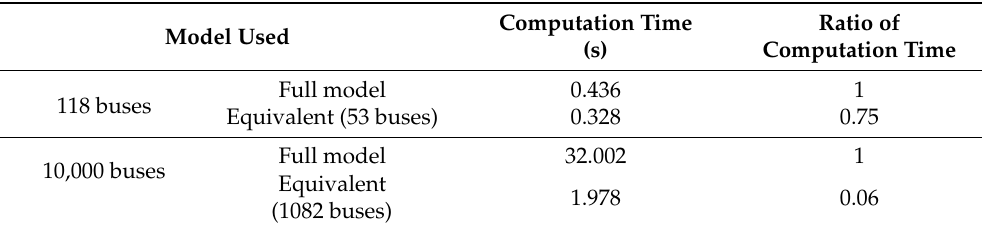
Table 4. Computational time